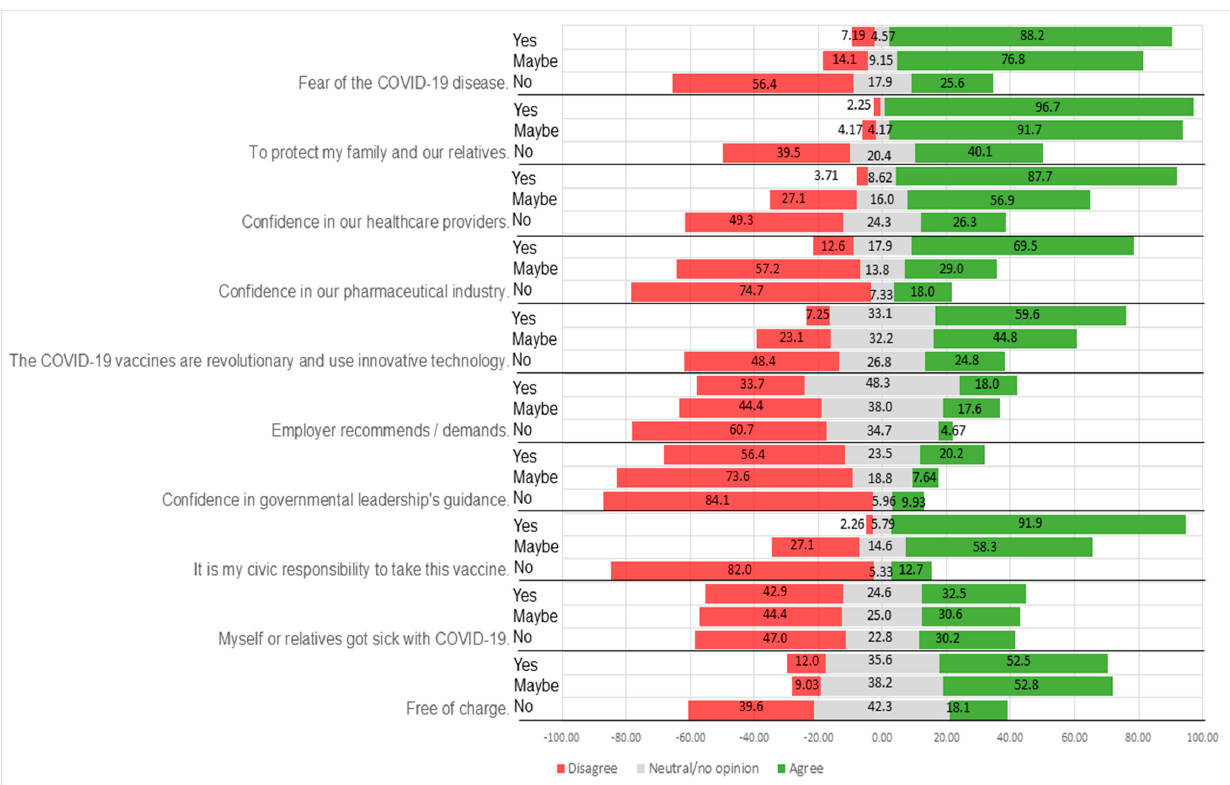
Figure 2. Likert plot of the reasons of the participants in the survey for taking or not taking the COVID-19 vaccine. Table 4. Reasons for taking, or not taking, the COVID-19 vaccine as stated by the participants in the survey. Overall ( n = 1644) Yes ( n = 1340) Maybe ( n = 145)